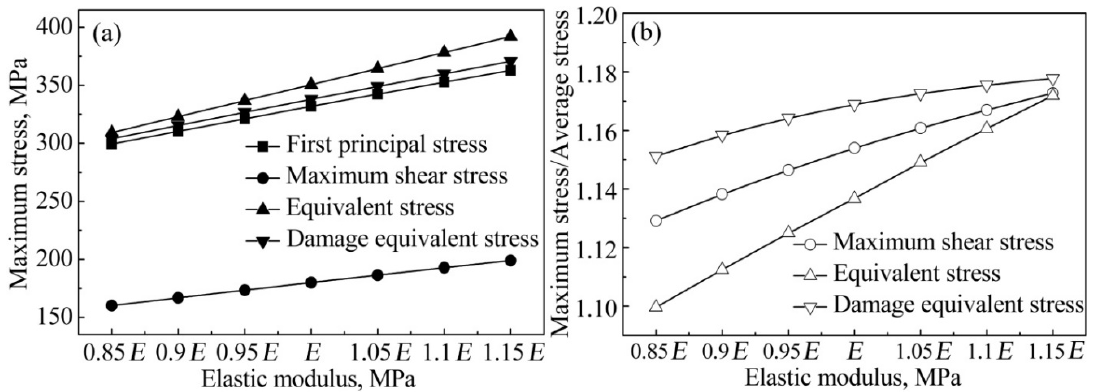
Figure 5. Influence of elastic moduli on ( a ) the maximum stresses and ( b ) the ratio between the maximum stress and the average stress in the TLP bonded joint.